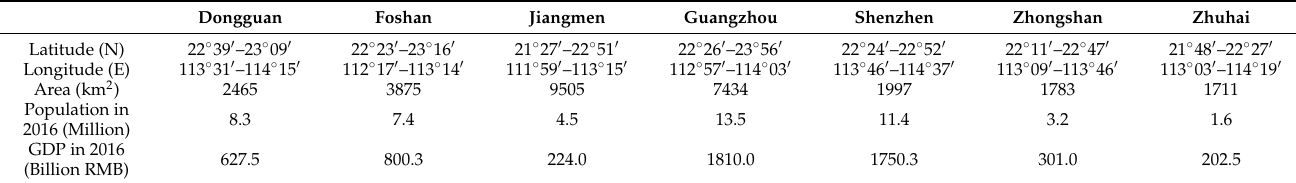
Figure 1. The location and administrative divisions of the study area: ( A ) Guangdong province in China, ( B ) the seven cities in the Pearl River Delta Urban Agglomeration, and ( C ) the topography (from NASA Digital Elevation Model data) of seven cities and the main rivers across them. Table 1. The basic conditions of the seven major cities in the Pearl River Delta Urban Agglomeration (data acquired from Urban Agglomeration in the Pearl River Delta Yearbook 2016).